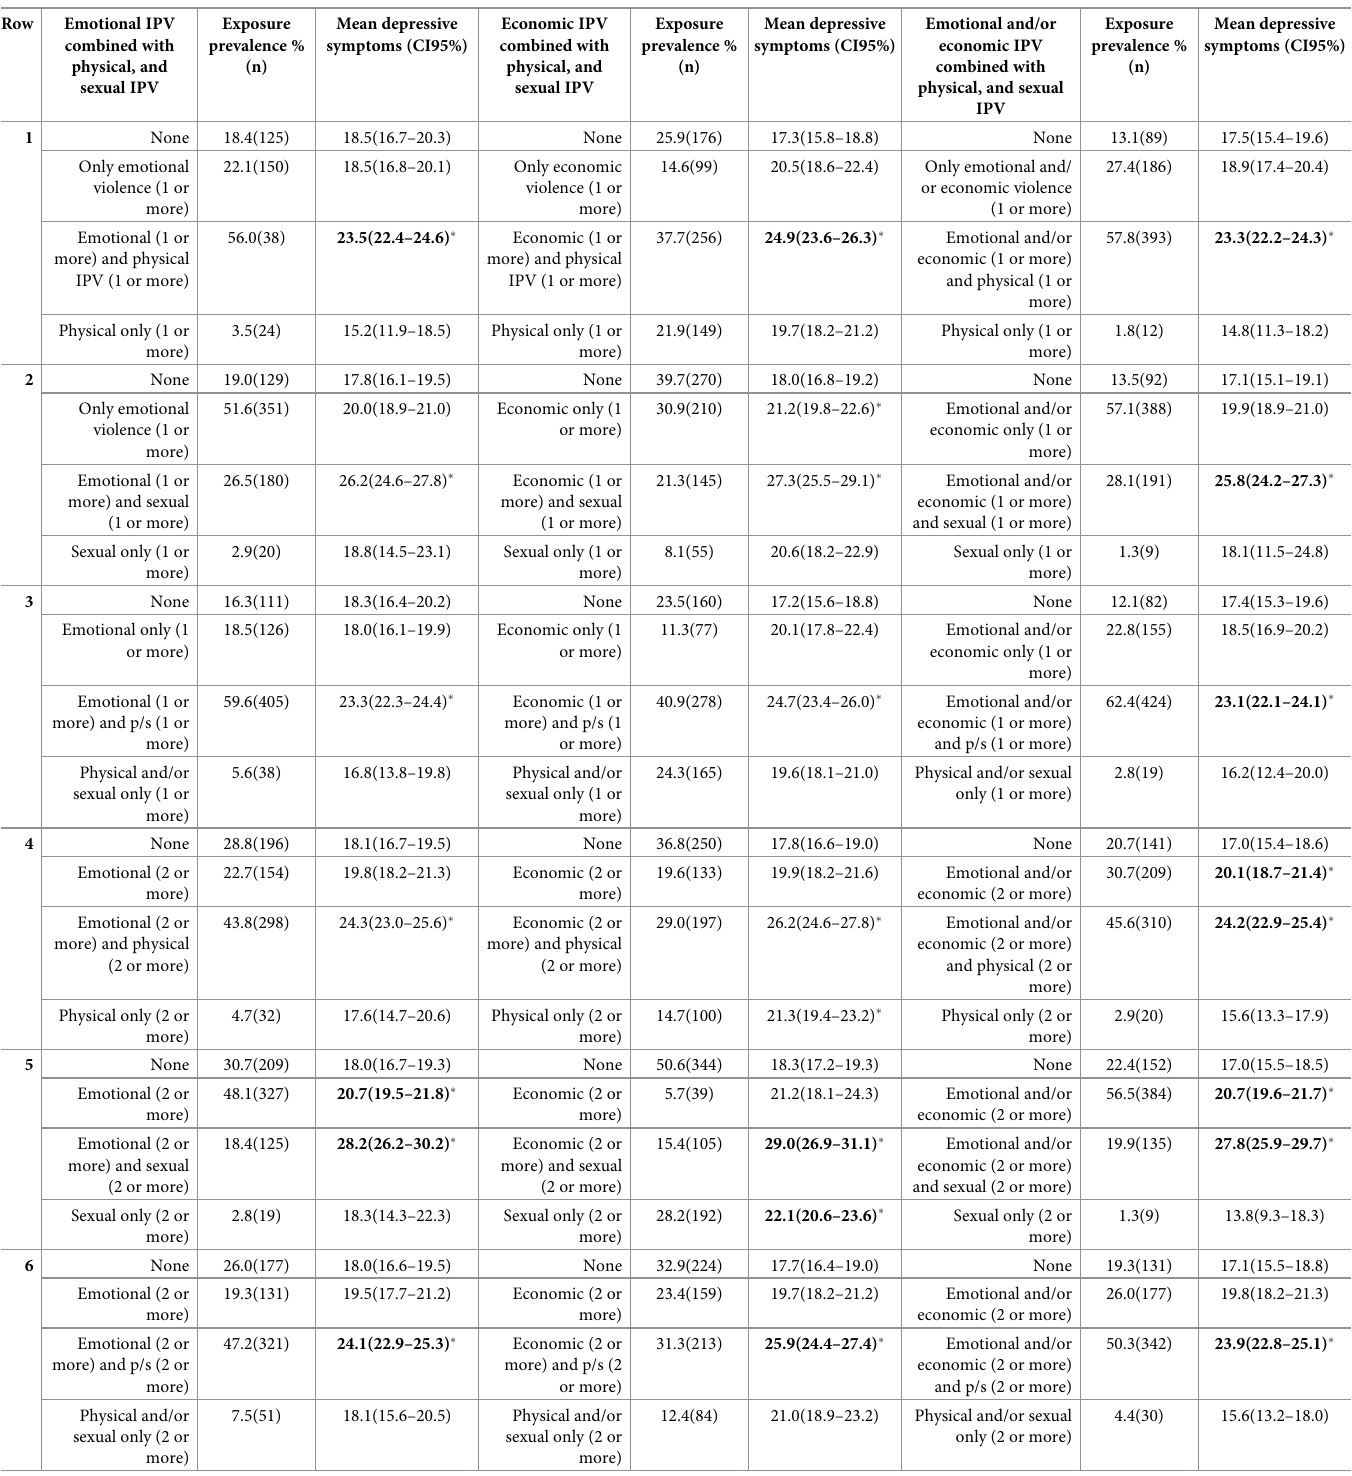
Table 4. Descriptive associations between combined forms of IPV and depressive symptomology. Row Emotional IPV combined